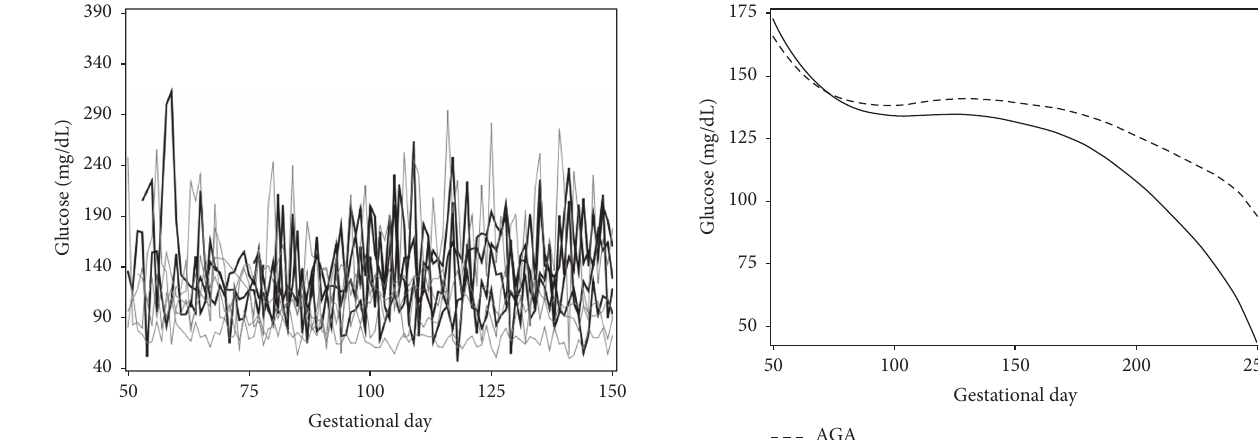
Figure 1: The glucose readings ( 𝑦 -axis, in mg/dL) of 5 randomly selected women with type 1 diabetes are plotted against gestation time ( 𝑥 -axis, in days). These profiles show large variation both between and within subjects during pregnancy.